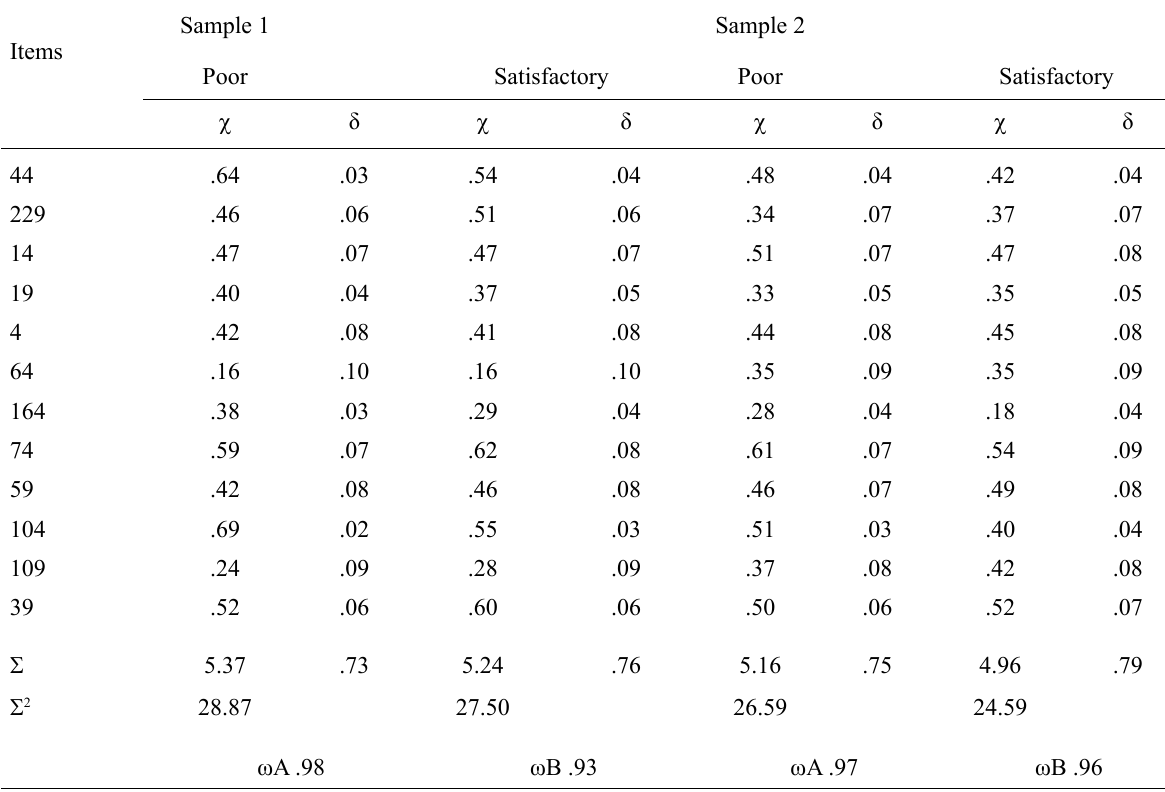
Table 4 Completely Standardized MLE Parameter Estimates for Poor and Satisfactory Fitting Single-Factor Models: Agreeableness Sample 1